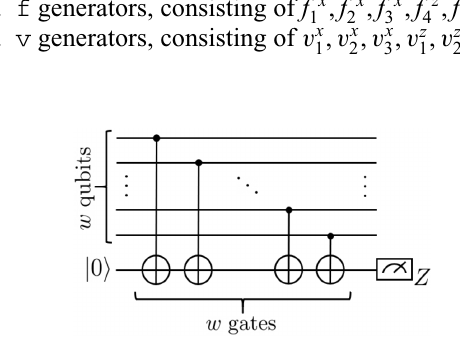
FIG. 3. A nonflag circuit for measuring a Z -type generator of weight w for the 3D color code of distance 3. The ordering of the CNOT gates for each generator has yet to be